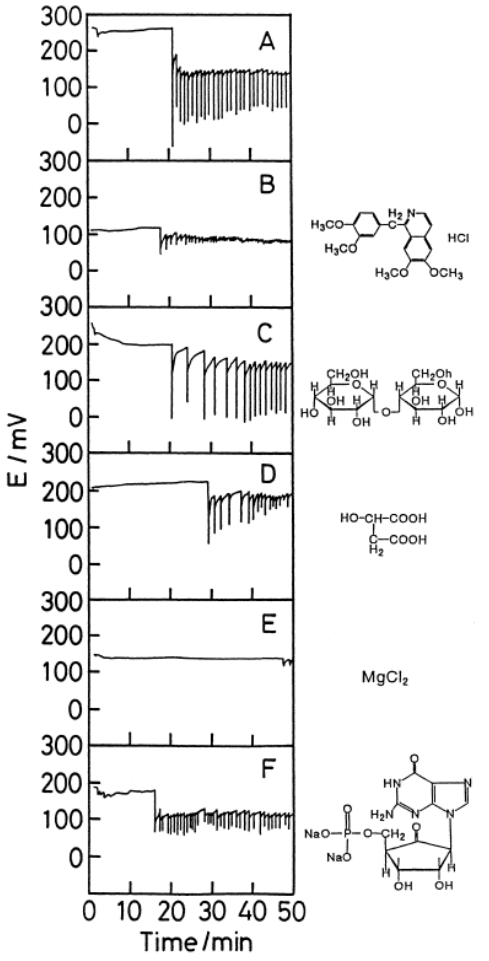
Figure 7: Oscillation patterns in the liquid membrane system in the presence of test substances in the acceptor phase: (A) without a taste substance, (B) 10 mM papaverine hydrochloride (bitterness), (C) 1 M maltose (sweetness), (D) 100 mM malic acid (sourness), (E) 100 mM magnesium chloride (saltiness), (F) 100 mM disodium guanosinate (umami). Reprinted with permission from [26]. Copyright 1998